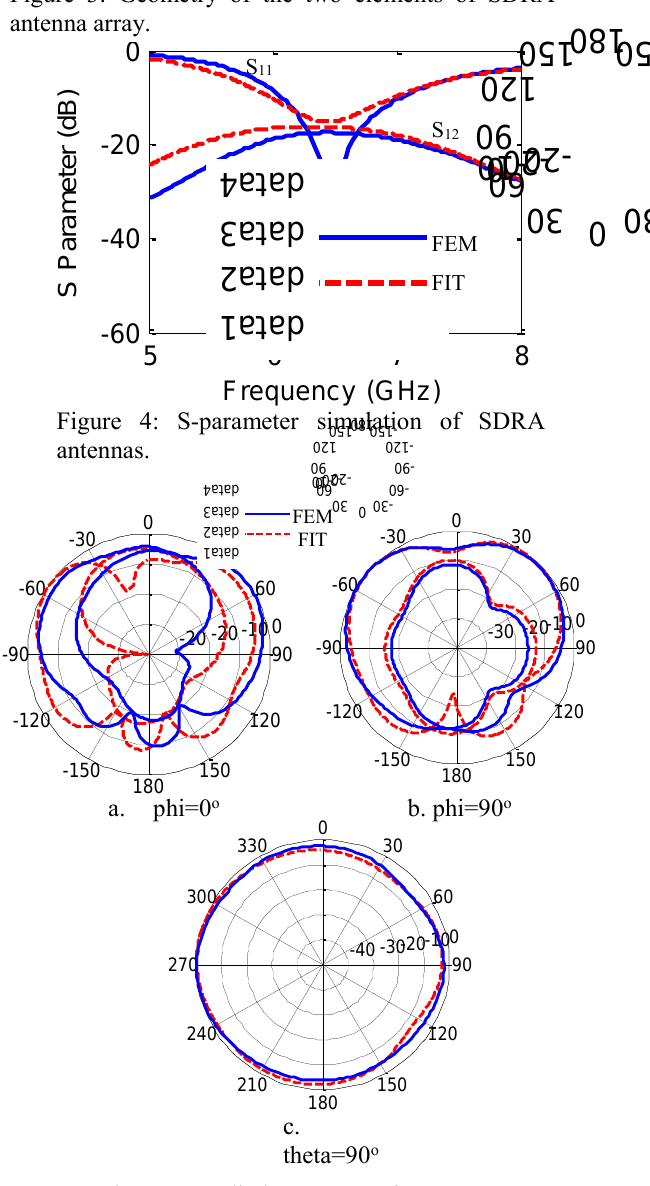
Figure 5: Radiation pattern of two SDRA at frequency 6.5 GHz.